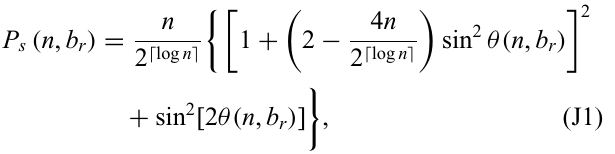
FIG. 9. Quantum circuit for preparing the clock state ( K = 2). Note that the last time difference M − 1 − m (cid:19) a copying operation followed by flipping the qubits.